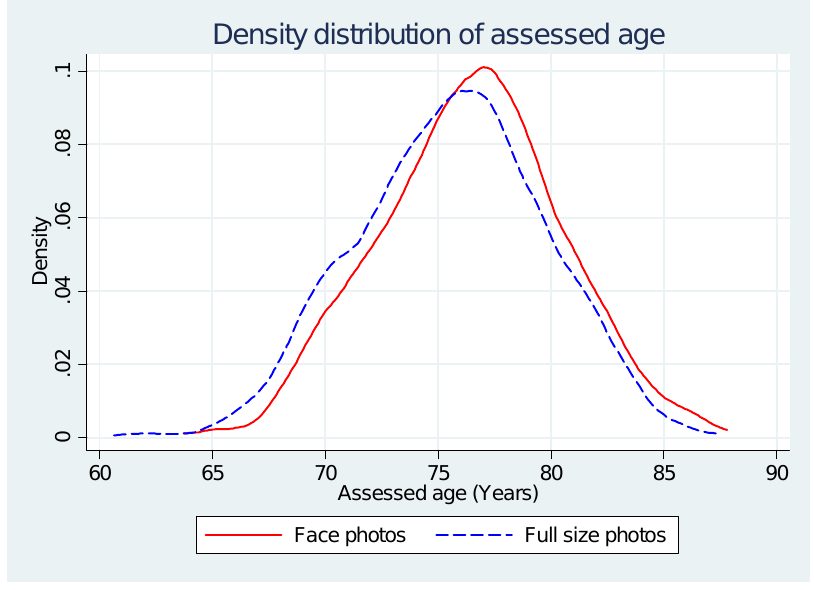
Figure 1 . Assessed age in face photographs and full length